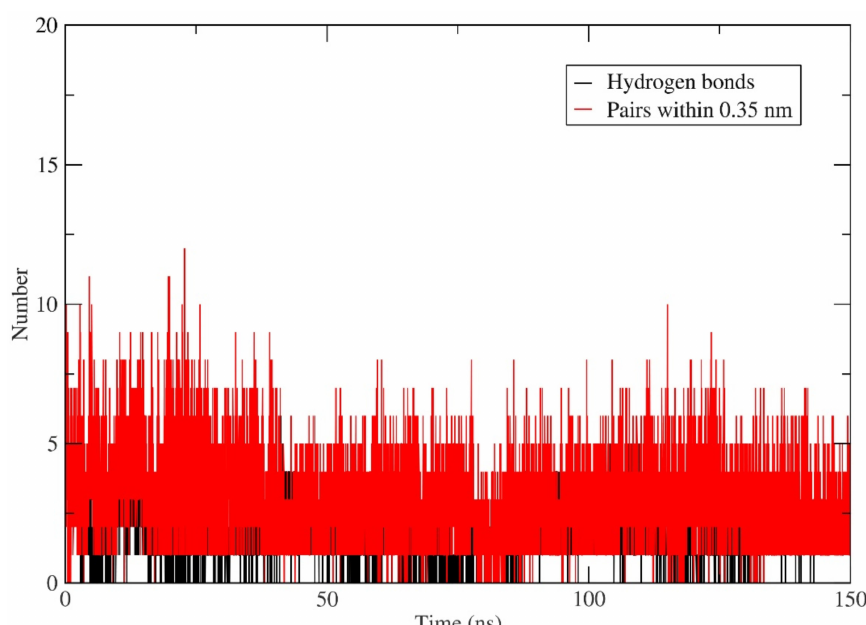
Figure 10. Estimation of the hydrogen bond interactions during the whole